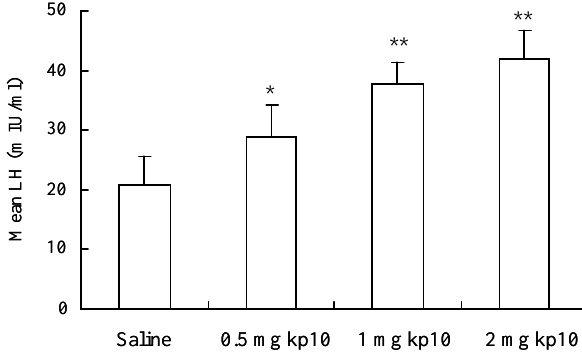
Figure 2. Mean concentration of LH in prepubertal ewes which received intravenous injection of 0, 0.5, 1 or 2 mg of kisspeptin-10 (kp10) dissolved in 5 ml of saline at 0 min. * p<0.05, ** p<0.01 as compared with that in saline